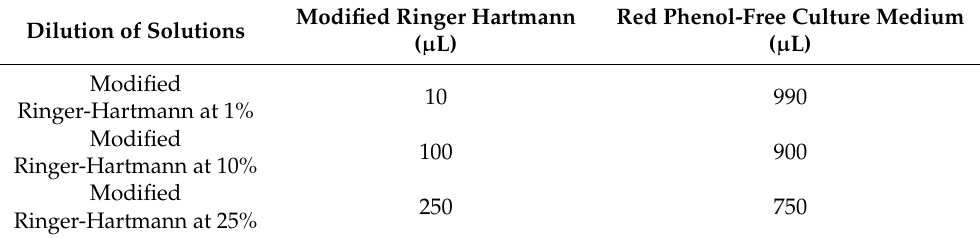
Table 1. Preparing artificial saliva solutions at different concentrations for the cytotoxicity